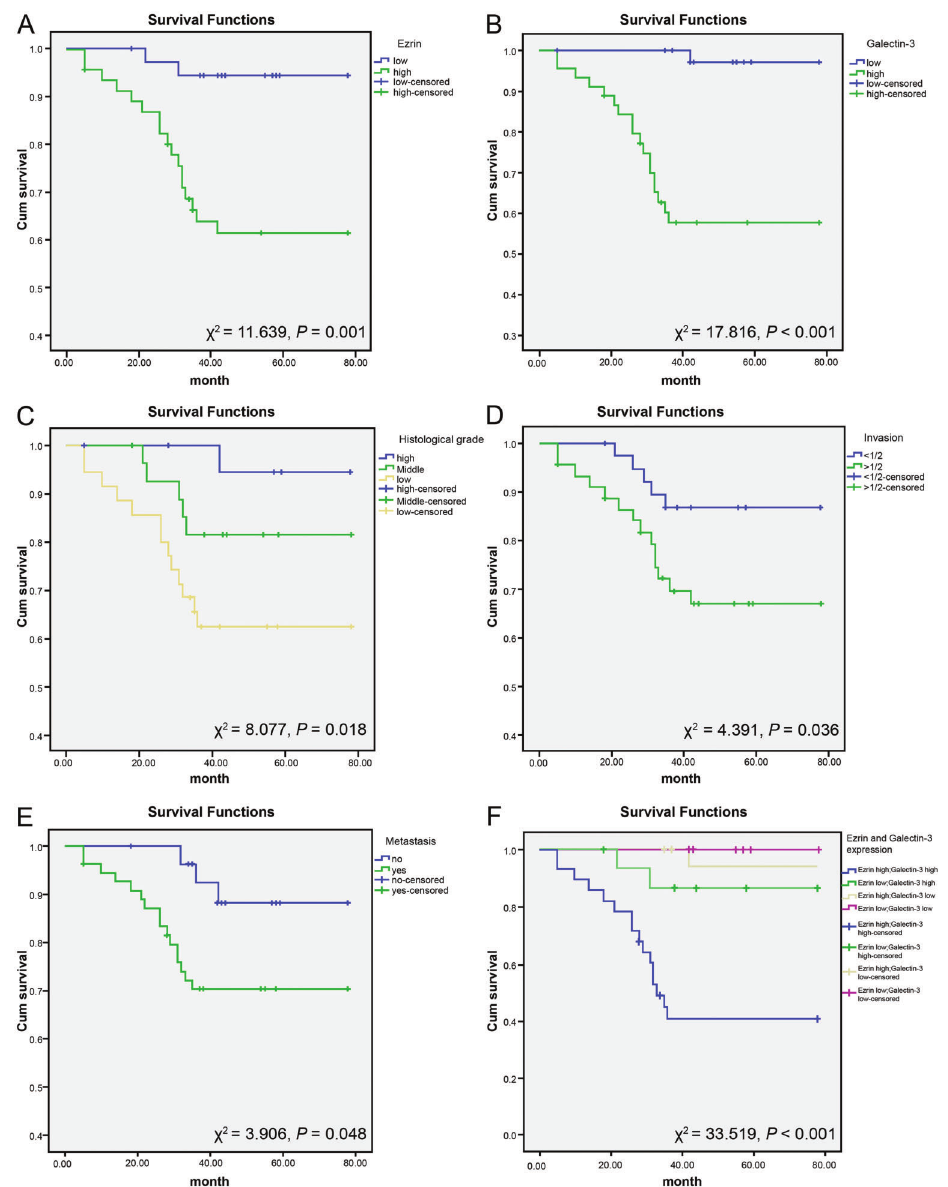
Figure 2. Kaplan-Meier curves for ezrin ( A ), galectin-3 ( B ), histological grade ( C ), stromal invasive depth ( D ), lymph node metastasis ( E ), and overexpression of ezrin and galectin-3 ( F ). cum survival: cumulative